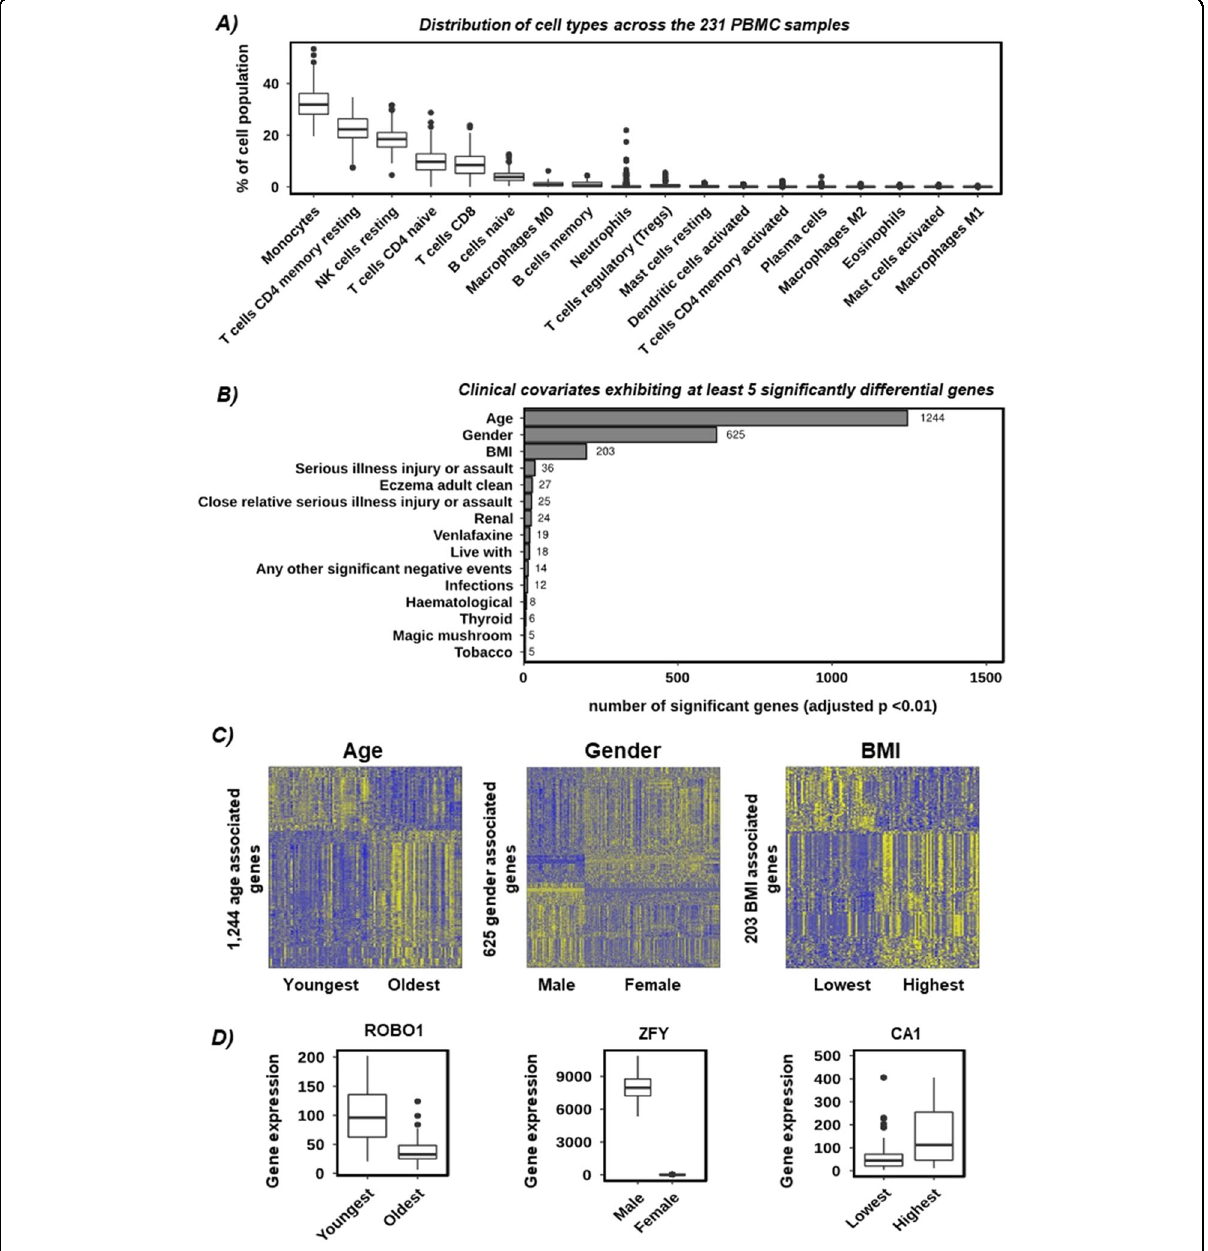
Fig. 1 Quality control and identi fi cation of confounding variables. A Distribution of immune cell types across all 231 PBMC samples. Cell types are shown on the x -axis, and the percentage of the cell population that is described by each cell type is shown on the y -axis. Each box represents all 231 samples. B Bar chart showing the number of signi fi cantly different genes (DESeq2 adjusted p value < 0.01) across all clinical parameters with at least fi ve signi fi cant genes. C Gene expression heatmaps highlighting the size and consistency of the confounding effects of age (left), gender (middle), and BMI (right) on the PBMC RNA-seq data. Samples are given by column and differentially expressed genes (adjusted p < 0.01) by row. Colour intensity indicated row scaled ( z -score) gene expression, with blue as low and yellow as high. D Gene expression boxplots of the most signi fi cantly different gene between youngest and oldest (ROBO1), male and female (ZFY), and lowest and highest BMI (CA1). Sample groups are shown on the x -axis and gene expression values (Corrected DESeq2 normalised counts) on the y